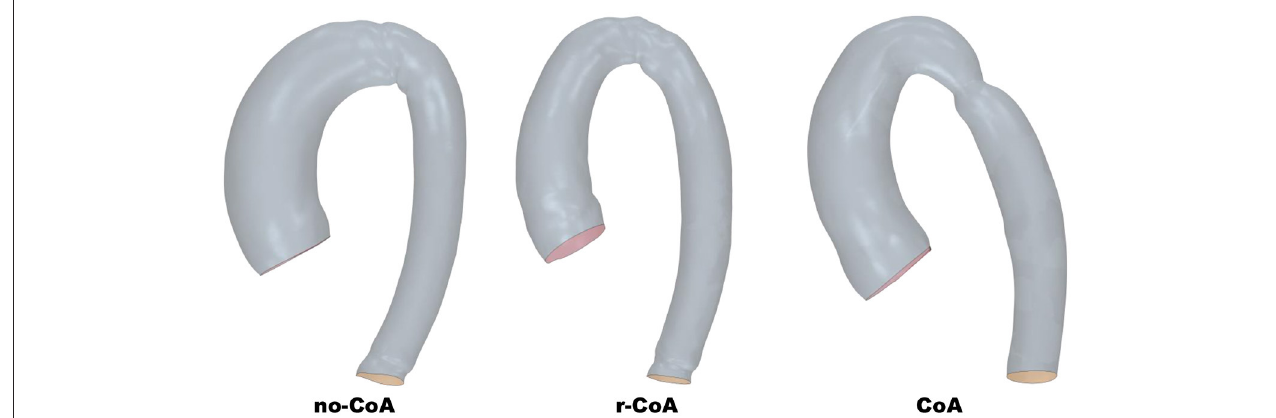
FIGURE 1 | Aortic geometries derived from statistical shape